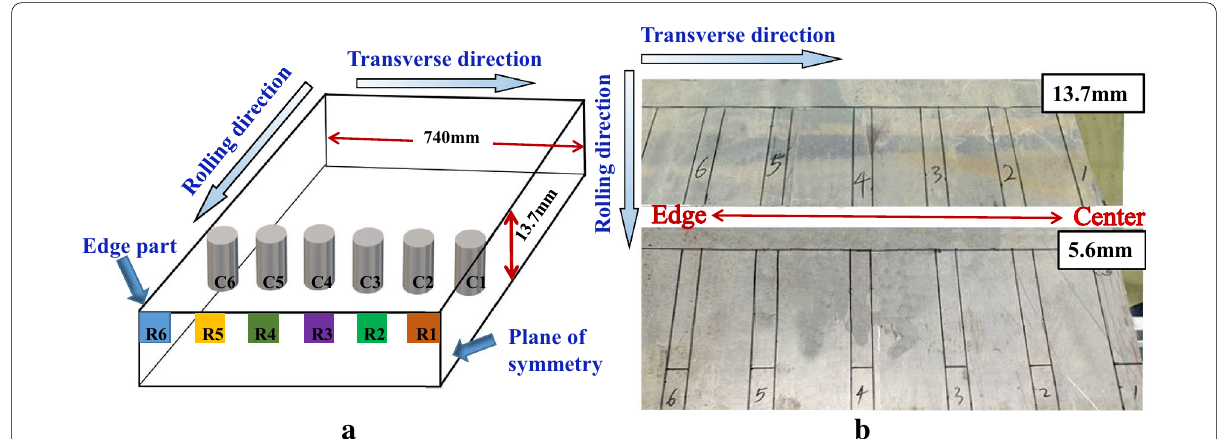
Figure 3 Schematic of the corresponding sampling sites between hot compression and rolling: ( a ) schematic of compression, ( b ) schematic of the actual